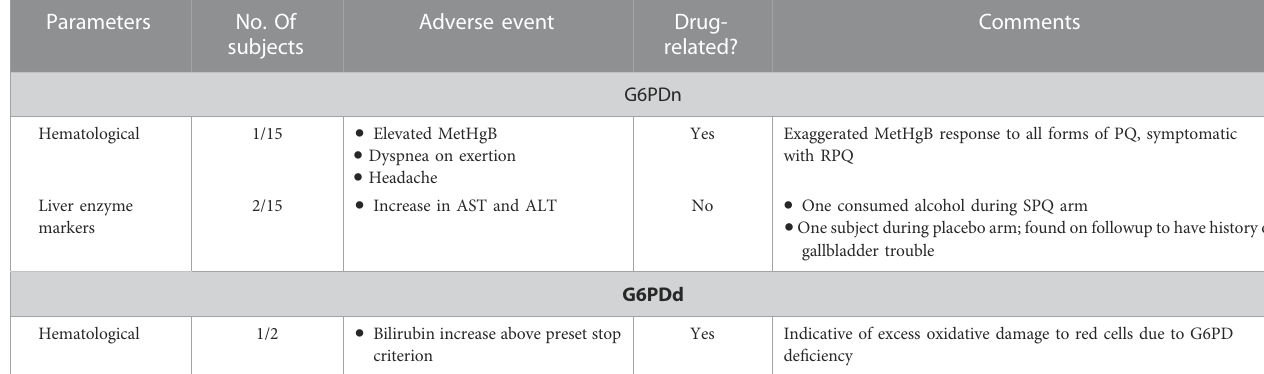
TABLE 2 Adverse events in G6PDn and G6PDd subjects during 7 days oral administration of PQ and its enantiomers. Parameters